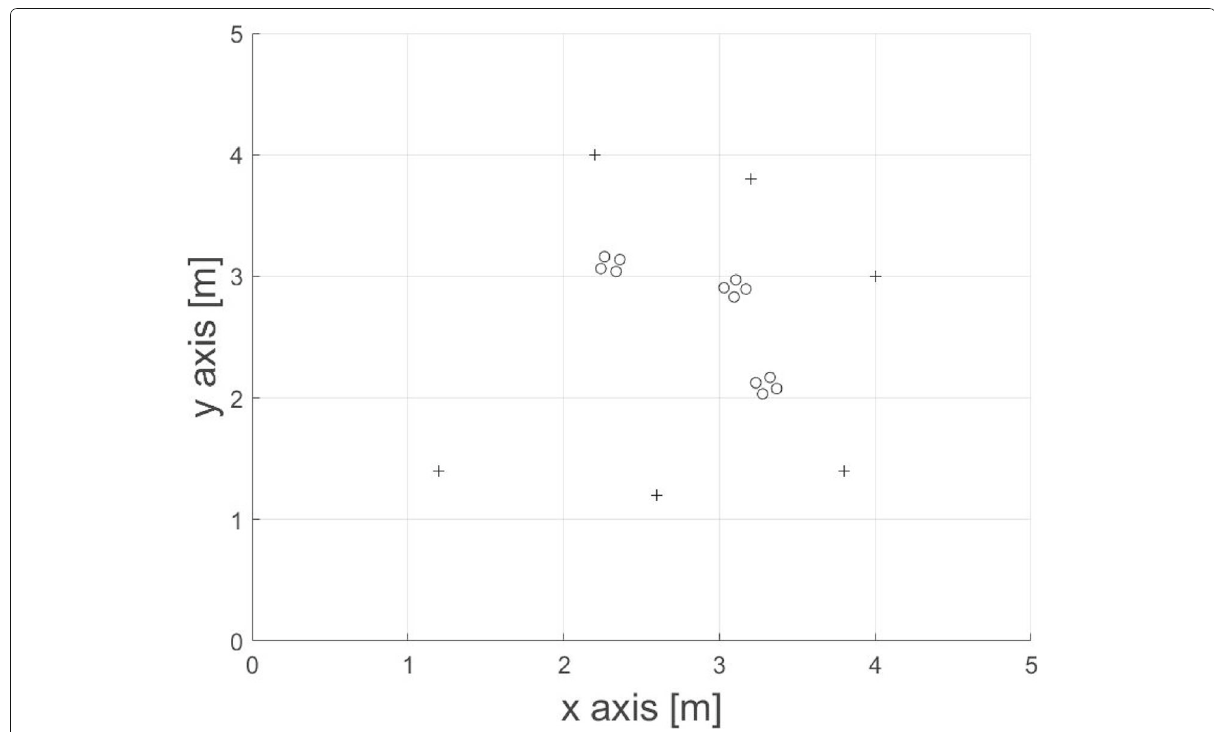
Fig. 3 Simulation room random setup example. Each microphone is denoted by the sign o . Six speakers are denoted by the sign